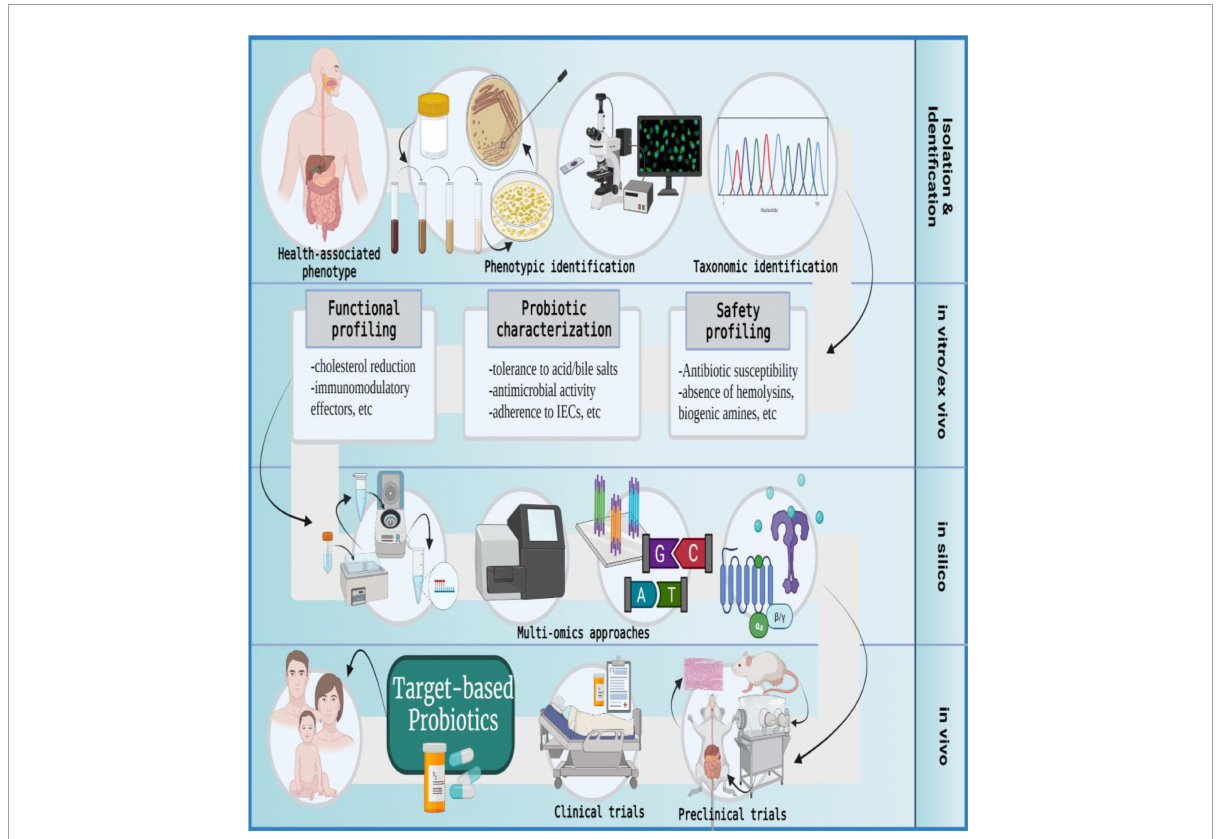
FIGURE6 The formulation of target-based probiotics. The formulation of target-based probiotics is based on understanding the action modality of probiotic strains via a multi-omics approach and then tailoring a probiotic formulation that produces molecular effectors to ameliorate a specific disease or indication; IECs, intestinal epithelial cells. The figure was drawn with